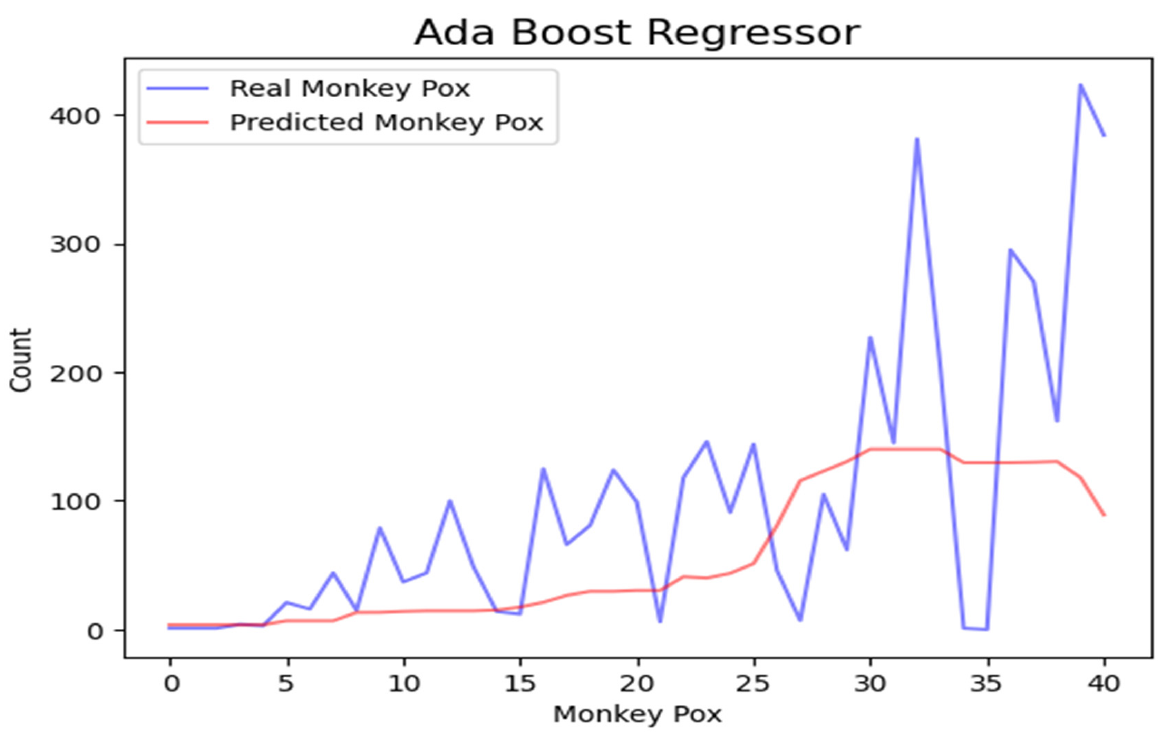
Figure 8. Comparison of Training time of machine learning.